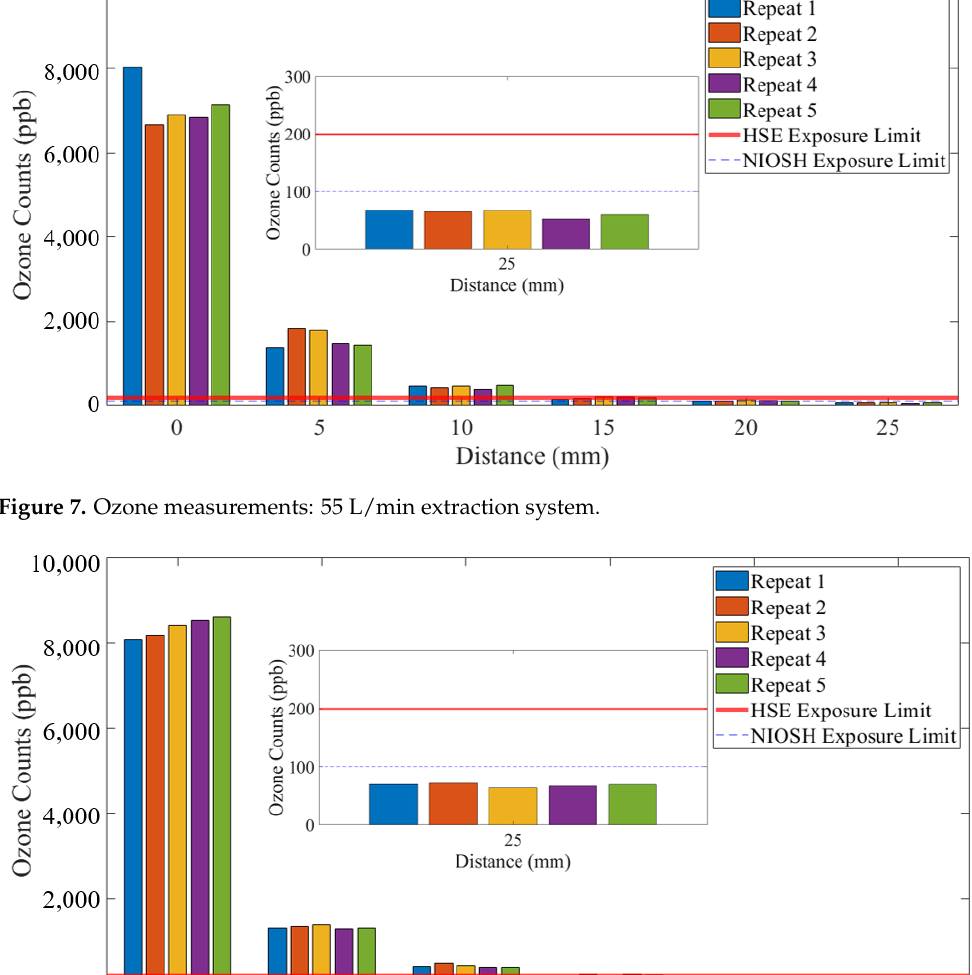
Figure 6. NOx measurements: 80 L/min extraction system.